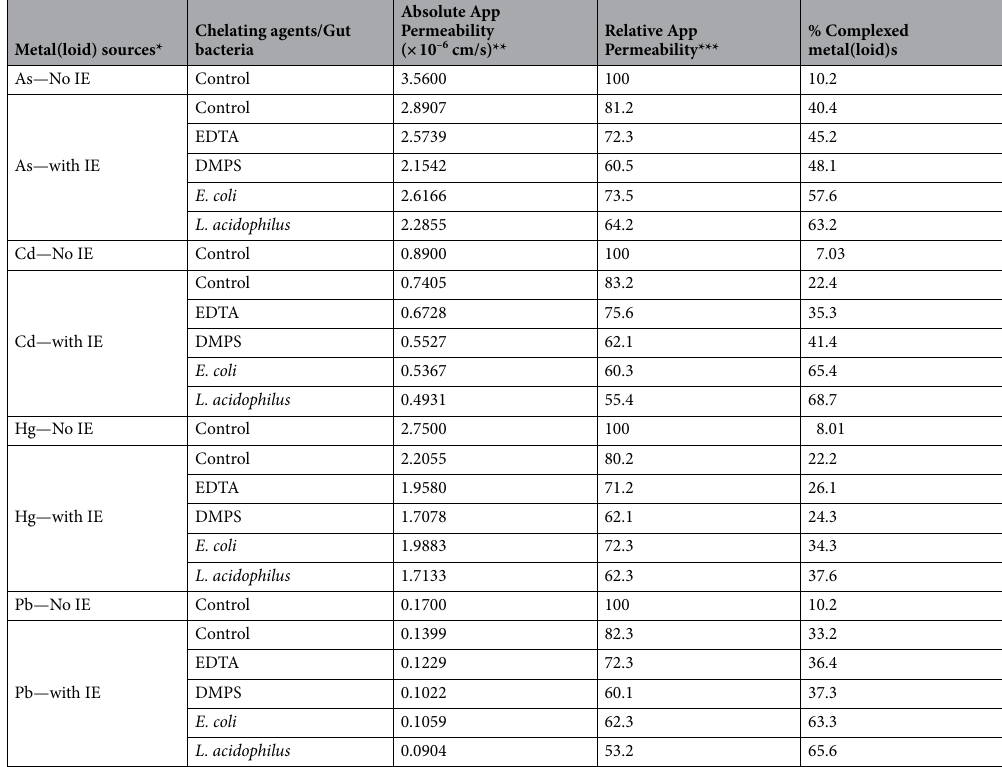
Table 3. Absolute and relative Apparent Permeability of metal(loid)s as measured by Caco-2 cell technique and percentage of metal(loid)s complexed. *NO IE, No Intestinal Extract; with IE, with Intestinal Extract; **Absolute Apparent permeability is calculated from Eq. (1) (× 10 –6 cm/s); ***Relative Apparent permeability is